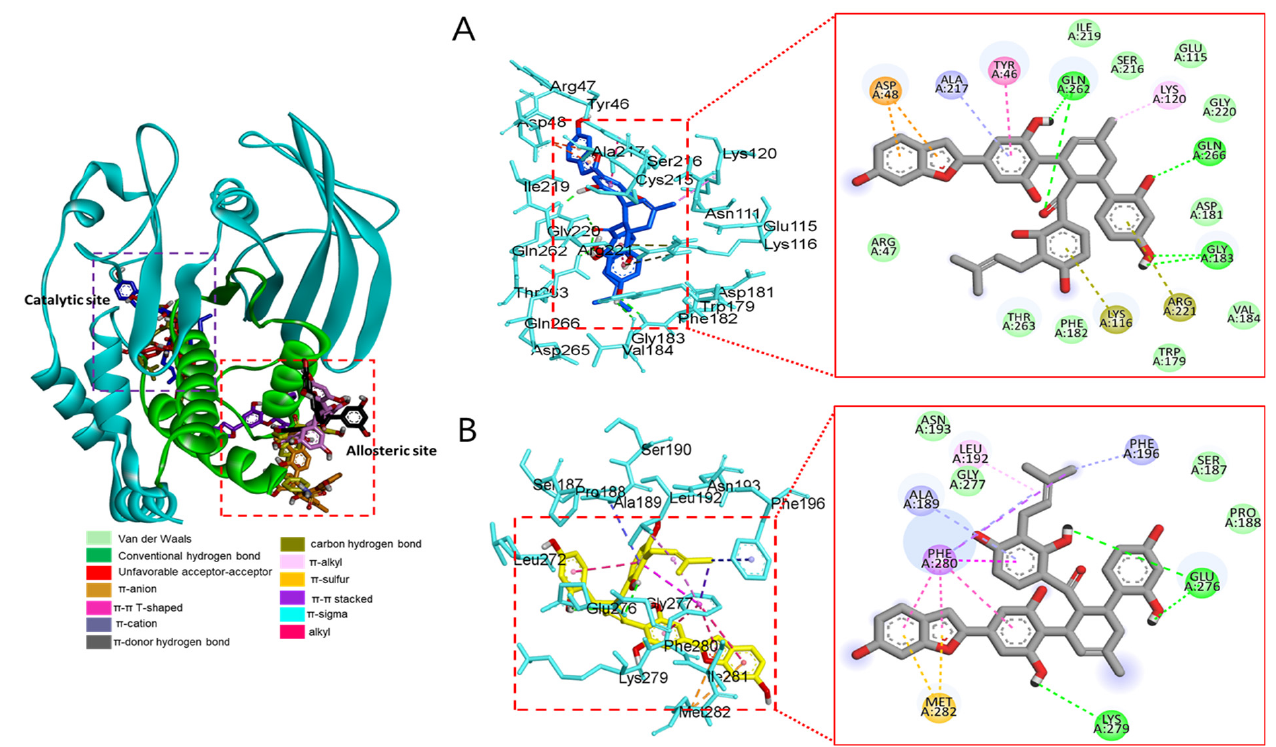
Figure 7. Molecular docking simulation models for PTP1B inhibition by chalcomoracin at catalytic site ( A ) and allosteric site ( B ). 3D ( left ) and 2D ( right ) docking simulations were shown at each binding site. Interaction was differentiated by various color ( left bottom ).